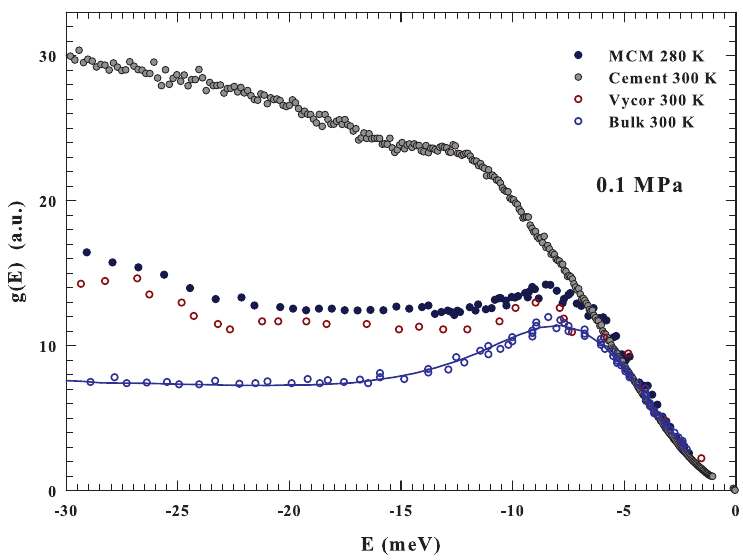
Figure 3. The figure reports, in the energy region − 30 to 0 meV, at about the ambient conditions (0.1 MPa and about 300 K) the DOS of bulk [34] and confined water. In the confined case, the G ( E ) data for water confined in Vycor (300 K) [34], silica MCM nanotubes (280 K) and the cement hydration water (300 K) [69] are reported. For the first three cases, a strong similarity can be